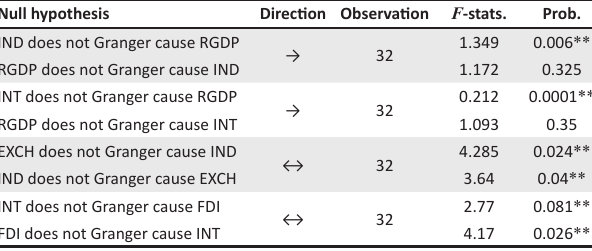
TABLE 5: Error correction model (dependent variables: real gross domestic product).